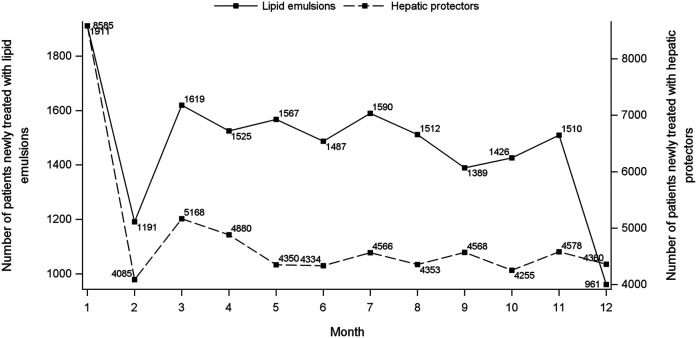
Waiting-time distributions of lipid emulsions and hepatic protectors. For each consecutive month during January to December 2015, the graph depicts the number of persons who presented their first recorded prescription of index (left Y-axis) and marker (right Y-axis) drug, respectively, during that month.